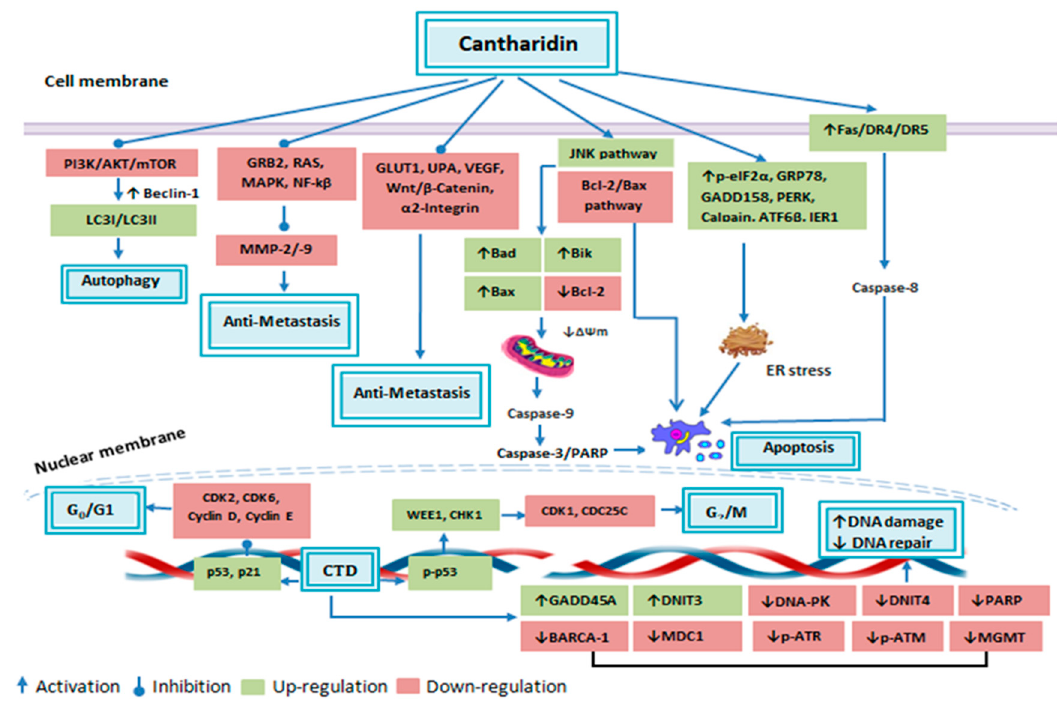
Figure 4. Anticancer attributes of cantharidin and its molecular targets.